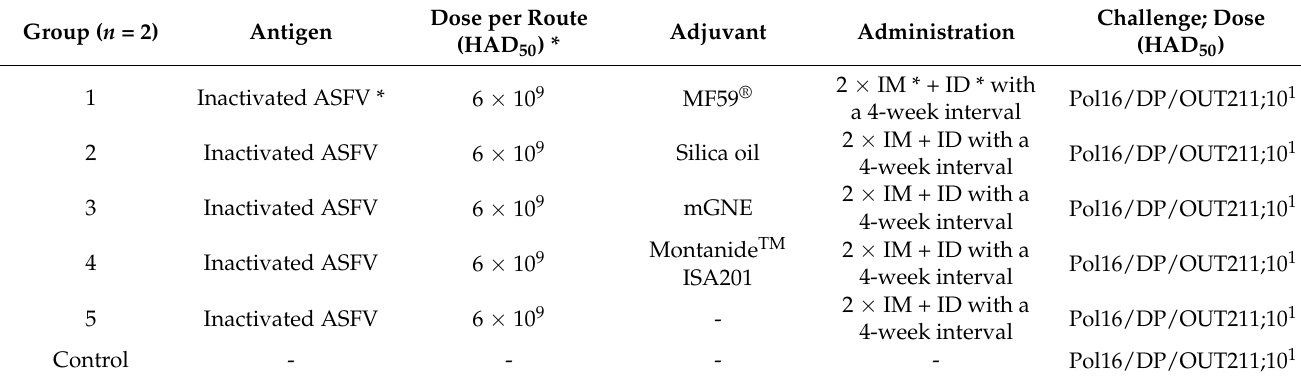
Table 1. Summary of the experimental